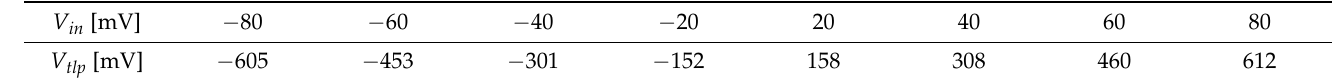
Figure 4. Circuit for adjusting the voltage generated on the shunt to the requirements of the Arduino platform. Table 2. Experimentally determined voltage at the output of the TLP7920 for some values of input.